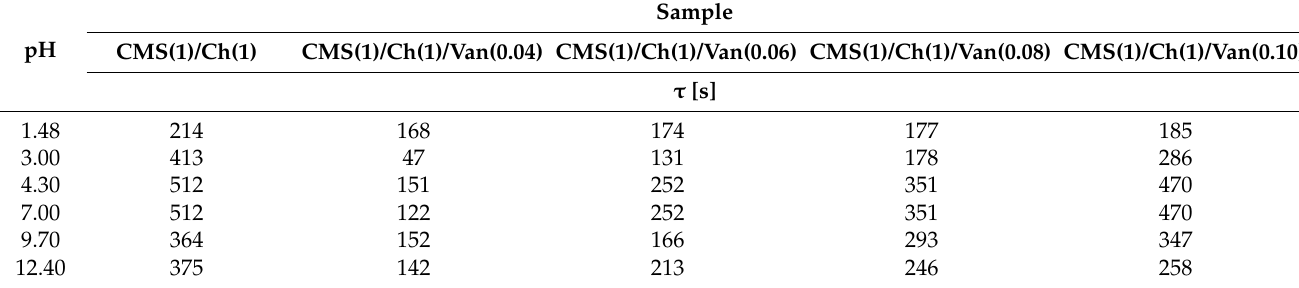
Table 6. Rate parameter in various pH buffers.